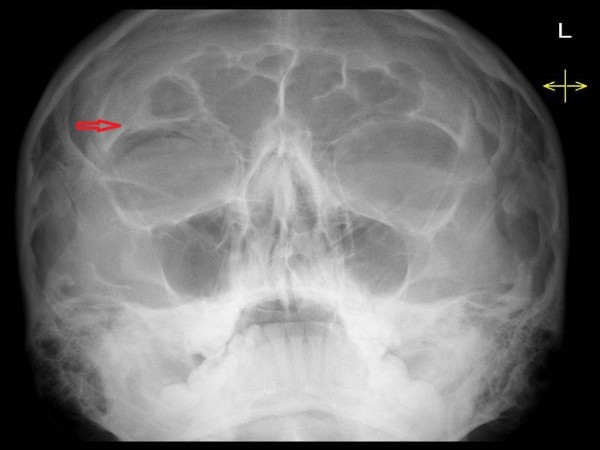
XR facial bones.